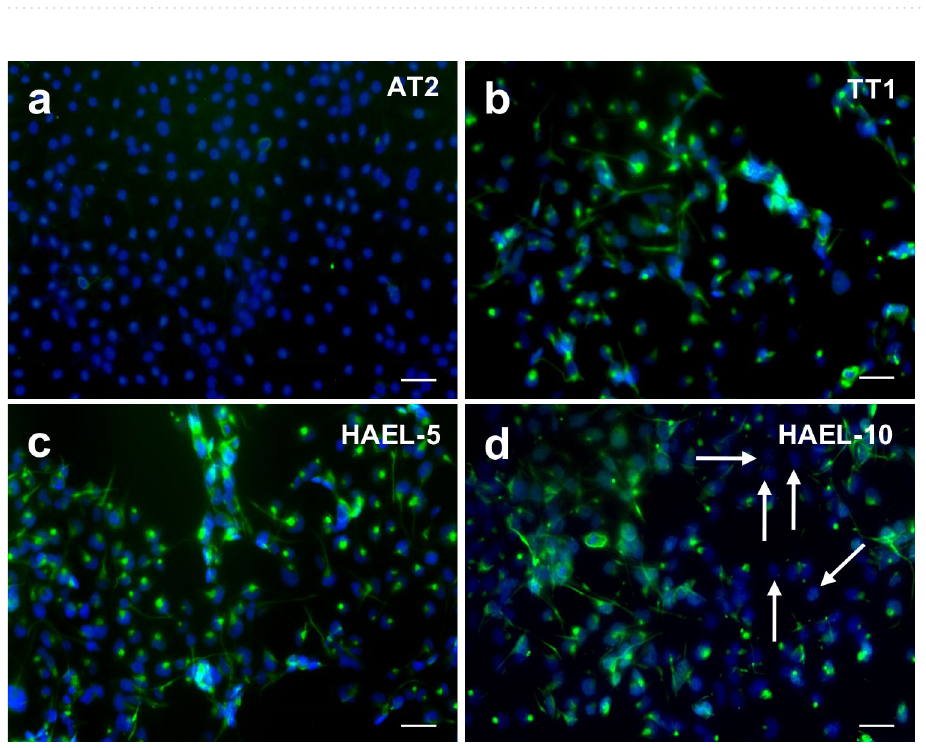
Figure 4. Immunofluorescent labelling of podoplanin (green) in AT2 cells ( a ), TT1 cell line ( b ) and ICs ( c , d ). Podoplanin is present in most of the cells but not in all of them (white arrows). Cell nuclei are stained blue. Bars = 50